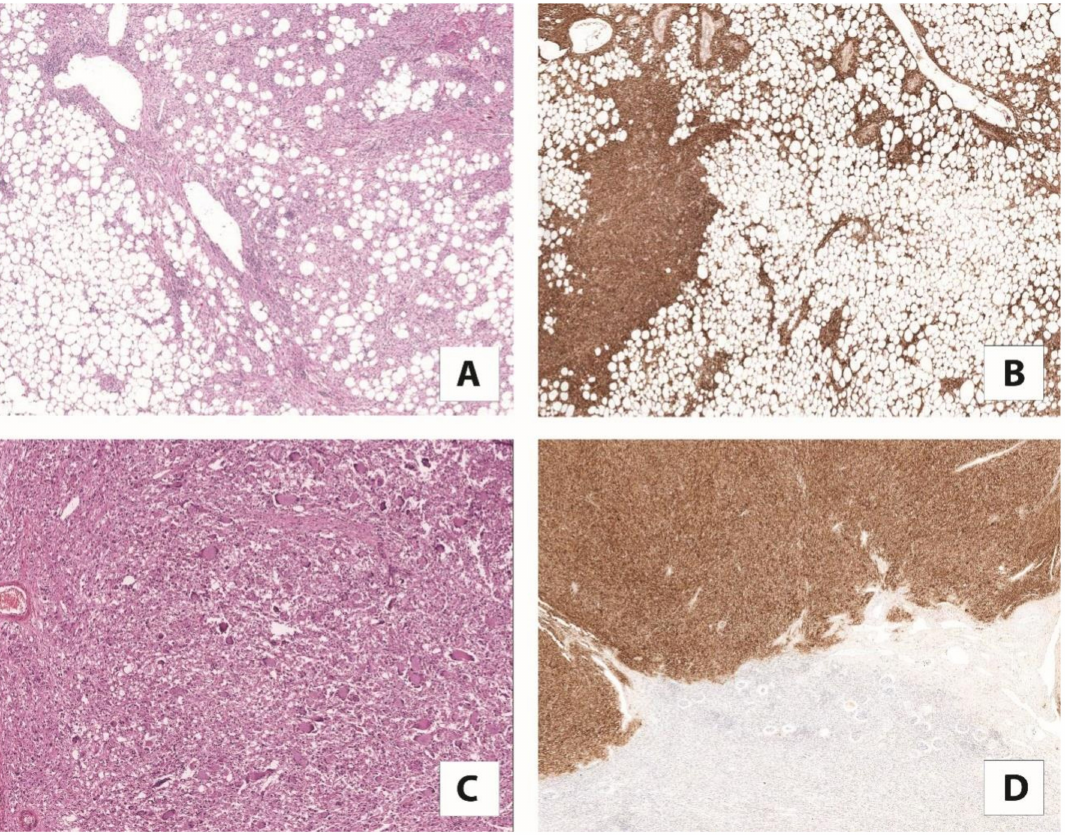
Figure 3. ( A ) Classic angiomyolipoma composed of vessels, smooth muscle, and adipose tissue with (5 × ) ( B ) a strong expression of cathepsin K (5 × ). ( C ) Pure epithelioid PEComa/epithelioid angiomyolipoma mainly consists of epithelioid cells (10 × ) ( D ) diffusely positive for cathepsin K (5 ×